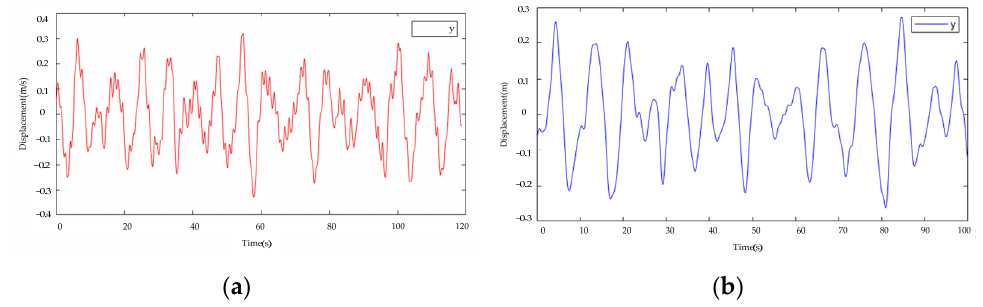
Figure 11. Data curve before and after smoothing filtering. ( a ) Data curves are not processed with smoothing filtering; ( b ) Smooth filter processing data curve.